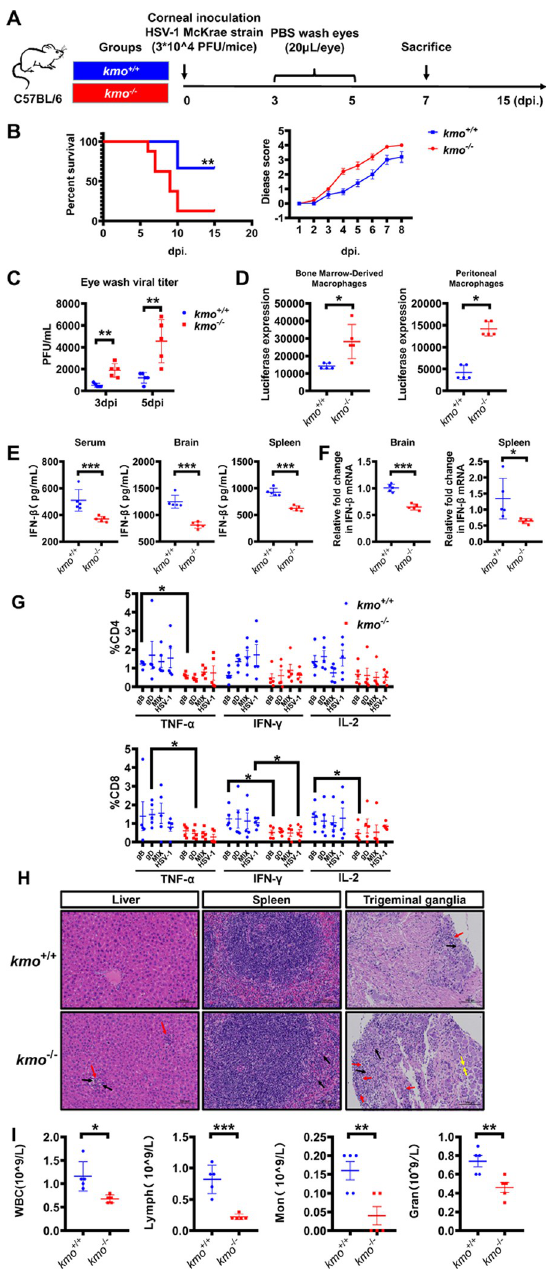
Fig 6. kmo -/- mice are more susceptible to viral infections. (A) Schedule for evaluating the susceptibility to viral infections in kmo -/- mice. Briefly, both kmo +/+ C57BL/6 mice and kmo -/- C57BL/6 mice were corneally inoculated with 3 × 10 4 PFU HSV-1 McKrae strain, disease symptoms of experimental mice were monitored until 15 dpi. (B) Survival curve and disease score of experimental mice in different groups over time post-infection (n = 8 per group). (C) The HSV-1 titer in the eye washing fluid at 3 dpi and 5 dpi was measured by plaque assay (n = 5 per group). (D) Bone Marrow-derived and Peritoneal macrophages were isolated from kmo +/+ or kmo -/- mice and then infected with HSV- 1-Luc at MOI of 0.25 for 8 h. Then, the luciferase expression was measured by Luciferase Assay kit (n = 5 per group). (E) The concentration of IFN- β in serum, brain, and spleen of experimental mice at 7 dpi was measured by ELISA assay (n = 5 per group). (F) The expression of IFN- β in the brain and spleen of kmo +/+ or kmo -/- mice were measured by RT-qPCR (n = 5 per group). (G) The frequency of polyfunctional CD4+ and CD8+ T cell populations in kmo +/+ or kmo -/- mice was assessed by detecting the secretion of TNF- α , IFN- γ , and IL-2 cytokines response to HSV-1 peptide pool stimulation. (H) The pathological changes of experimental mice’s liver, spleen, and trigeminal ganglia (TG) were observed by hematoxylin-eosin (H&E) staining at 7dpi. The scale bars: 100 μ m. (I) The numbers of white blood